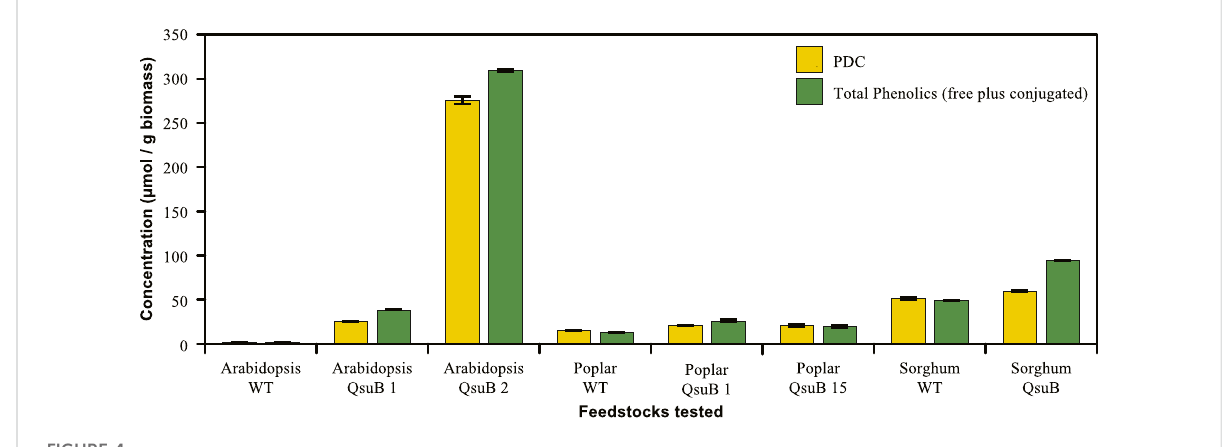
FIGURE 4 Comparison between the total normalized concentration of phenolics (free plus conjugated) and the concentration of 2-pyrone-4,6- dicarboxylic acid (PDC) produced after 48 h incubation with the N. aromaticivorans PDC